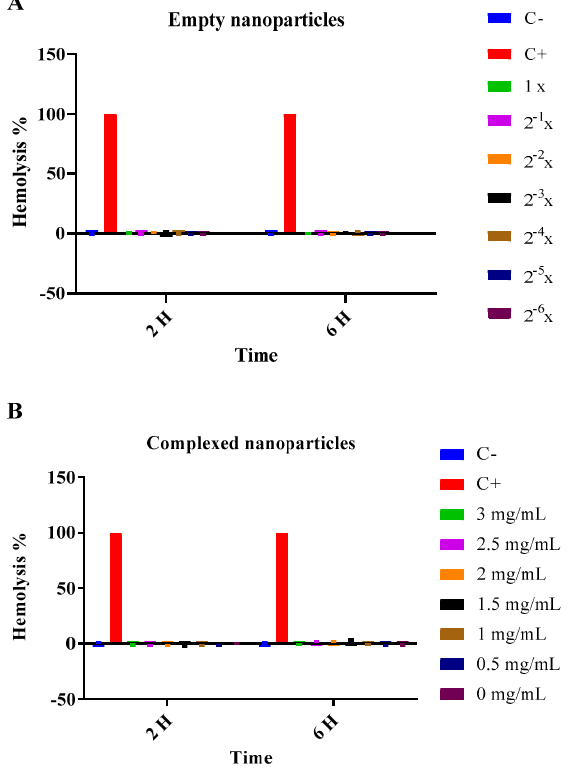
Figure 1. Hemolysis assay with empty or P10-complexed chitosan nanoparticles. Red Blood Cells were incubated with nanoparticles for 2 and 6 h and hemolysis was determined by absorbance measurement at 540 nm. Empty chitosan nanoparticles; ( A ) were serial diluted and concentrations ranged from 1× to 2 − 6 ×, with 1× being the initial concentration after preparation of the nanoparticles. The concentrations of P10-complexed chitosan nanoparticles; ( B ) varied from 3 mg/mL to 0 mg/mL. PBS was used as negative control (C − ) (0% hemolysis) and autoclaved distilled water was used as positive control (C+) (100% hemolysis).